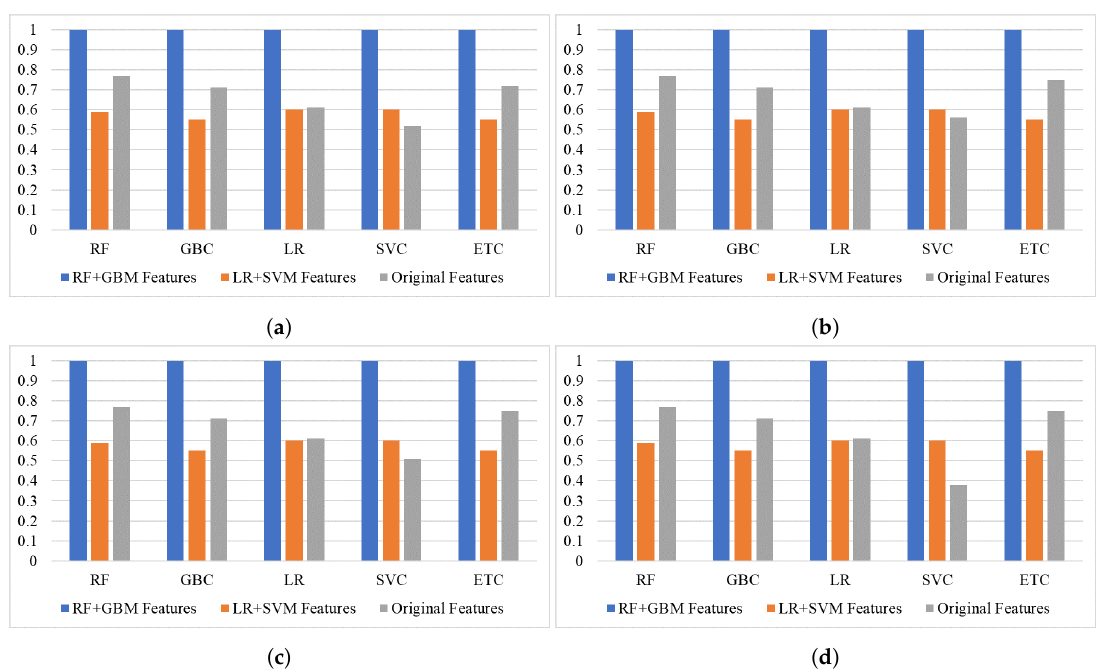
Figure 7. Performance comparison of models ( a ) Accuracy, ( b ) Precision, ( c ) Recall, and ( d ) F1